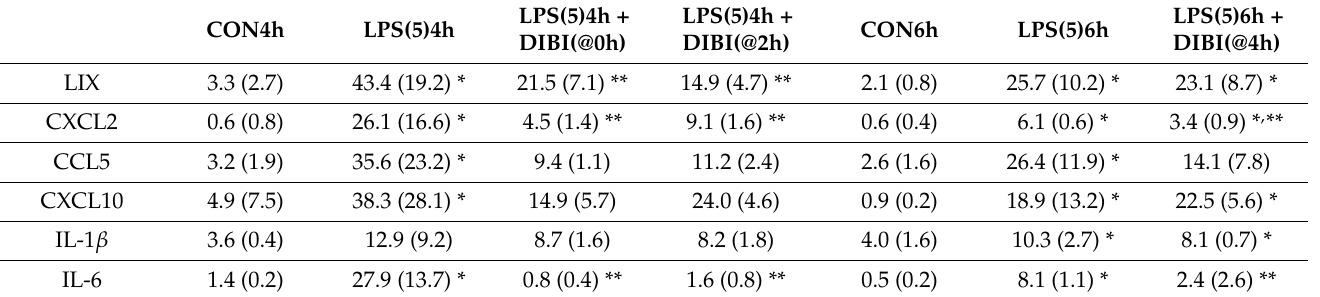
Table 1. Lung cytokine levels (normalized to total protein content, pg/mL, mean (SD), * p < 0.05 vs.